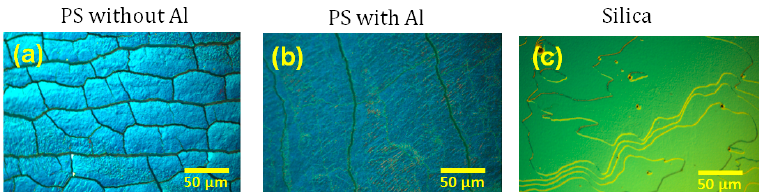
Figure 2. Microscopic images of colloidal crystals made from ( a ) polystyrene (PS), ( b ) PS covered with an Al layer, and ( c ) silica samples measured at Linac Coherent Light Source (LCLS). Series of X-ray diffraction images were recorded using the Cornell-SLAC Pixel Array Detector (CSPAD) megapixel X-ray detector [24], positioned 10 m downstream from the sample, that is